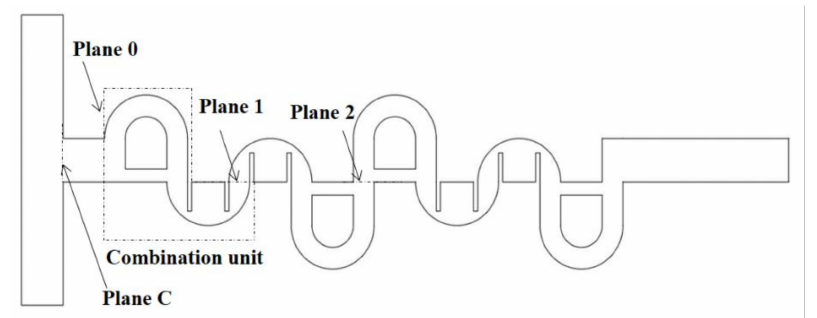
Figure 4. A micromixer created using four combination